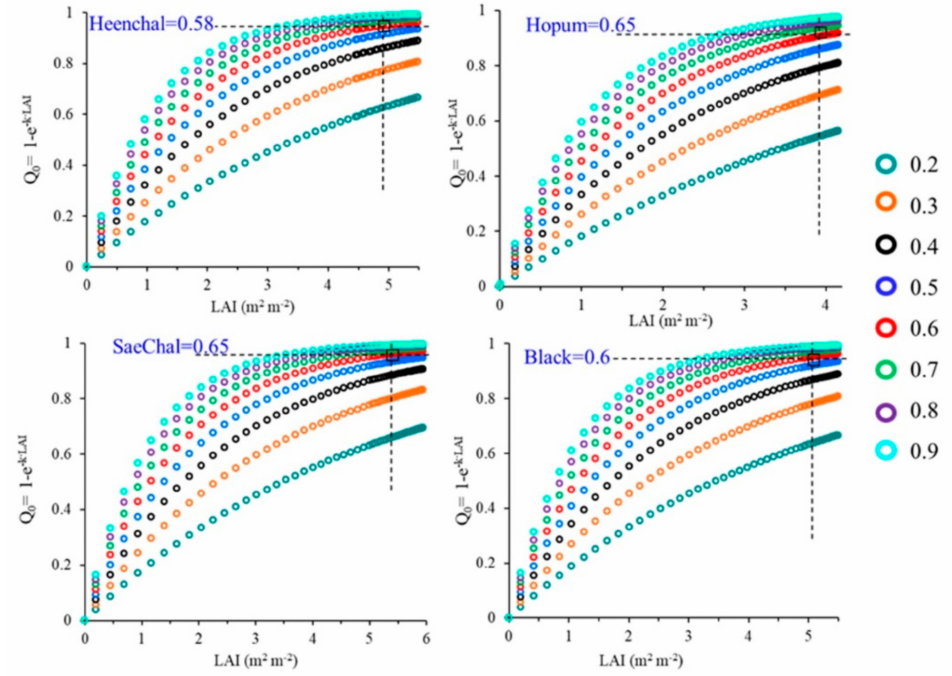
Figure 3. Determination of a light extinction coefficient (k = 0.62) based on the relationship between leaf area index (LAI) and canopy light interception (Q 0 = 1 − e -k*LAI ) for four barley cultivars.